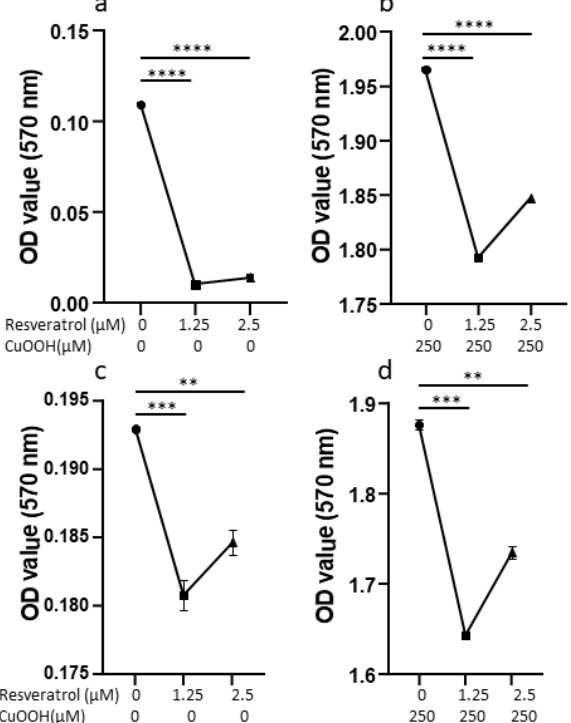
Figure 3. Effect of trans-resveratrol on oxidative stress on non-treated cells (panel ( a )) and effect of trans-resveratrol on oxidative stress on cells treated with CuOOH (panel ( b )). Horizontal bars indicate a statistically significant difference. Effect of resveratrol diastereomeric mixture on oxidative stress on non-treated cells (panel ( c )) and effect of trans-resveratrol on oxidative stress on cells treated with CuOOH (panel ( d )). Horizontal bars indicate statistically significant differences (**: p < 0.005; ***: p < 0.0005; ****: p < 0.00005).